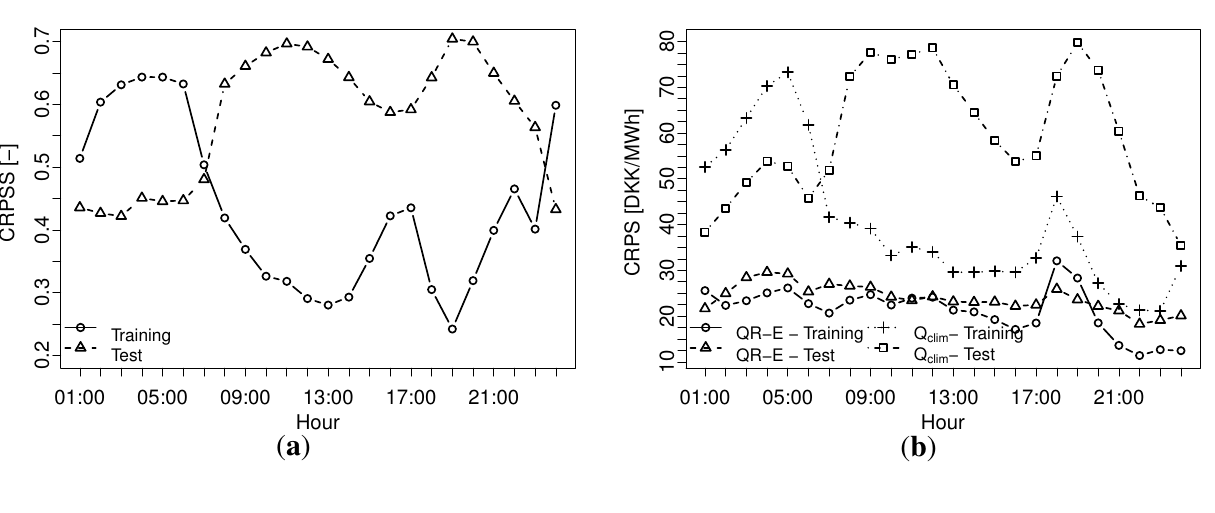
Figure 11. Forecasts generated by the QR-E model on 9/15/2009 at 10:00 for 9/16/2009 ( a ) and forecasts issued on 1/23/2010 at 10:00 for 1/24/2010 ( b